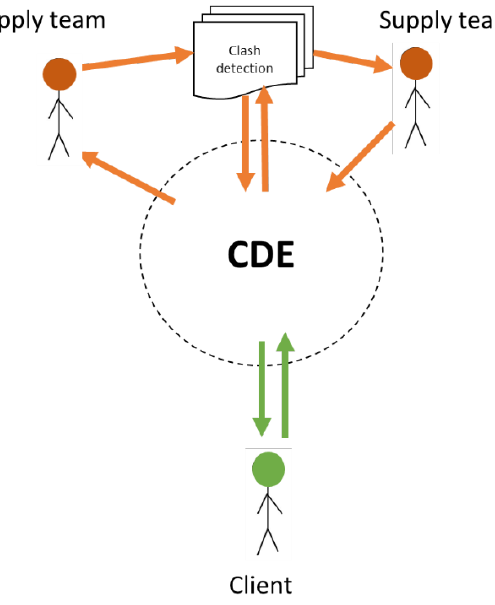
Figure 12. Communication involved in the BIM project.